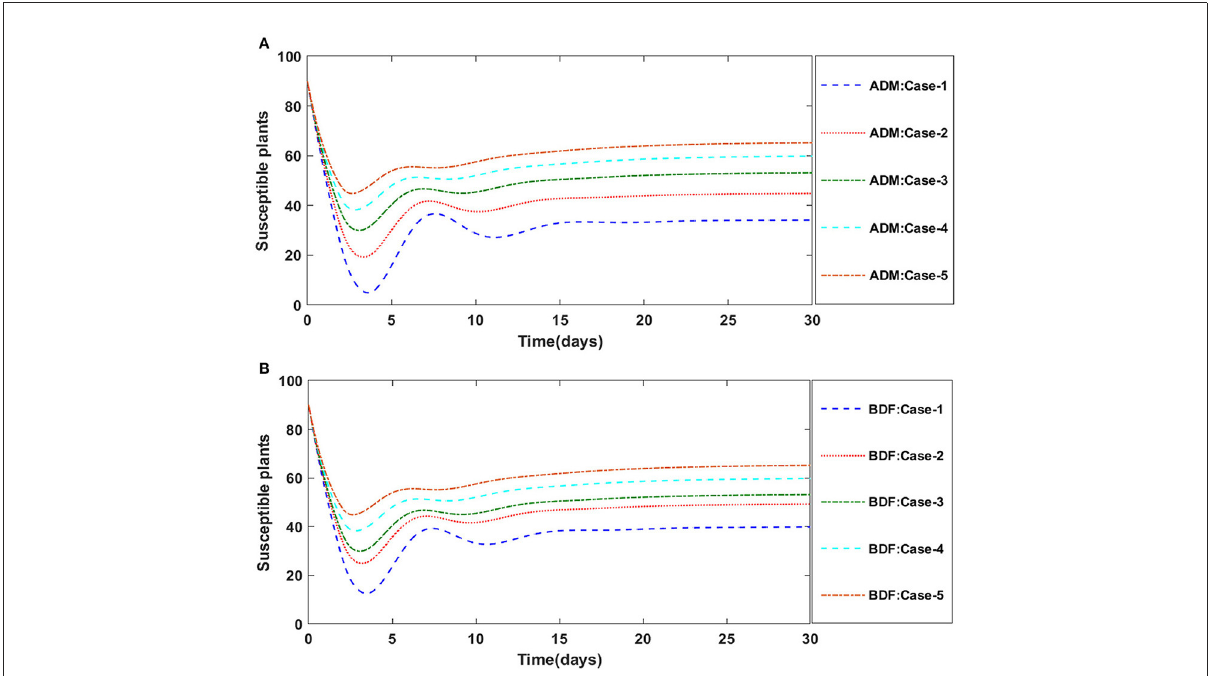
FIGURE6 (A) Dynamics of susceptible plants for the varition in υ using ADM for model A1. (B) Dynamics of susceptible plants for the varition in υ using BDM for model A1.